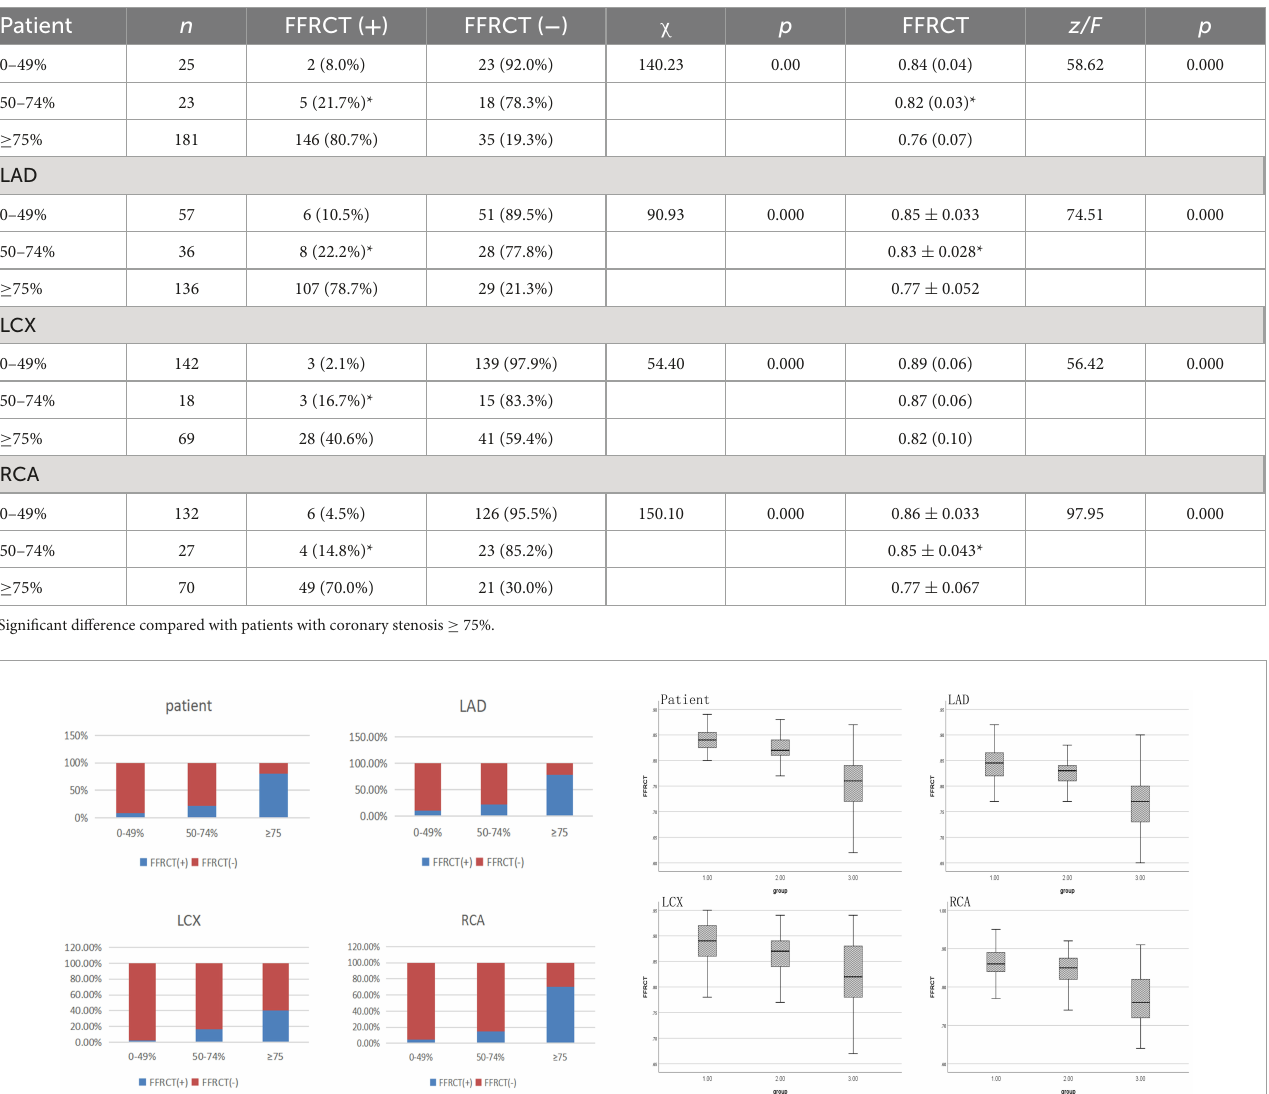
TABLE 3 FFRCT values of coronary arteries with different degrees of stenosis in coronary angiography.